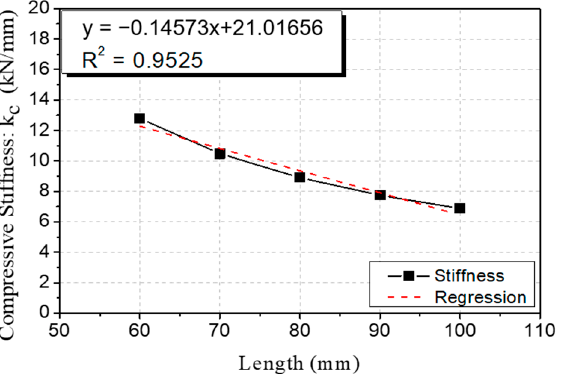
Figure 11. Relationships between compressive stiffness and length in Type 2 specimens. The relationships between the length and the maximum force under the same maximum strain condition were also observed between the compressive stiffness and the maximum force, considering the variation in the length of the specimen as a change in the compressive stiffness. As the compressive stiffness of each specimen decreased under the maximum strain conditions of 25%, 30%, 35%, and 40%, a decrease in maximum force was also observed, as presented in Figure 12, and the two variables displayed a relatively linear relationship. The R 2 values obtained through the linear regression analysis for the 35% and 40% maximum strain conditions were 0.858 and 0.840, respectively, and the relationships between the two variables were relatively clear. However, the 25% and 30% maximum strain conditions yielded the R 2 values of 0.1673 and 0.628, respectively, demonstrating weaker relationships between the two variables than the other strain cases.